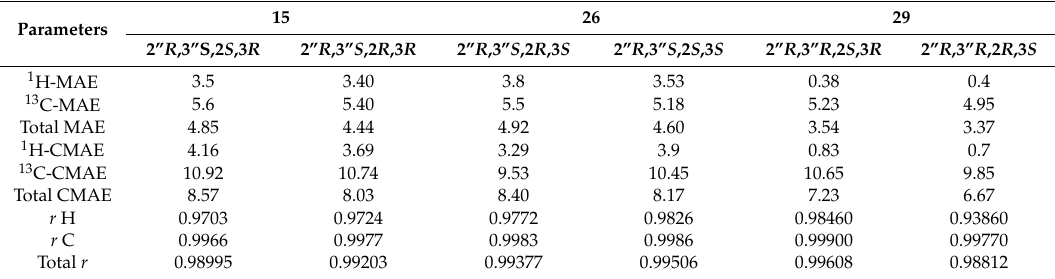
Table 4. Calculated mean average error (MAE), corrected MAE (CMAE), and correlation coe ffi cients of the pair of possible diastereomers for each compound.